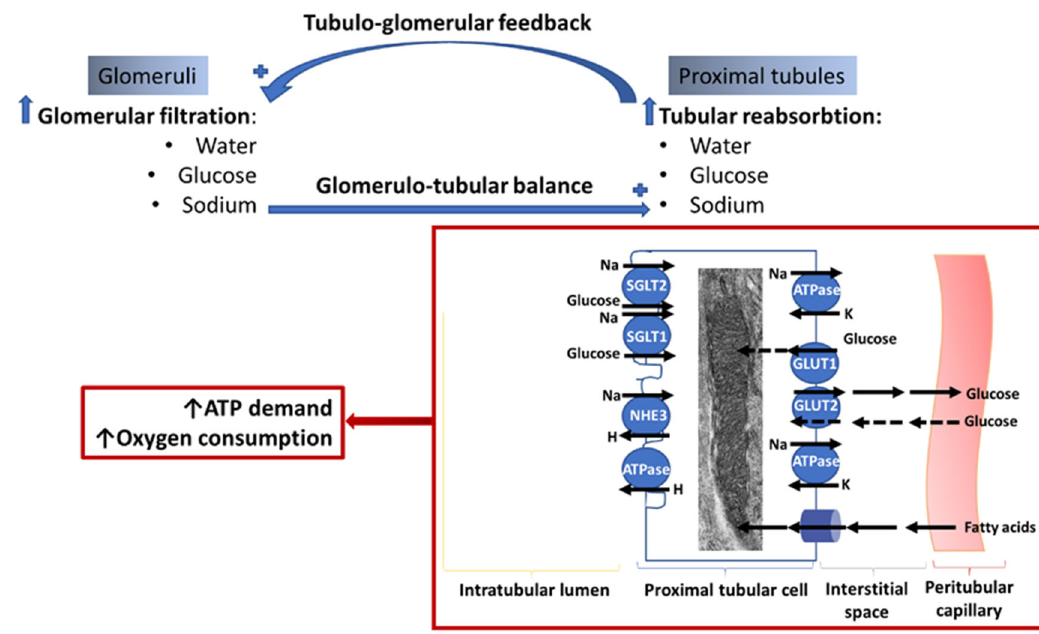
Figure 1. The crosstalk between glomeruli and proximal tubules is an energy-consuming process. The increased proximal tubular reabsorption of components within the glomerular filtrate involves apical transporters including Sodium Glucose Transporters (SGLT) 1 and 2, Sodium Hydrogen Exchanger 3 (NHE3), and Hydrogen ‐ ATPase. The gradients needed for the apical transport are provided by the Na-K ATPase. Glucose exits via basal GLUT2 to enter the peritubular capillaries. Hyperglycemia either reverse or impede the glucose transport via GLUT2 and facilitate the glucose uptake via GLUT1, thus favoring intracellular glucose accumulation. The major ATP source is fatty acid (FA) β‐ oxidation within the mitochondria; however, glucose can also be used for energy generation although the bulk is only in transit to be recovered from the urinary space to the blood.